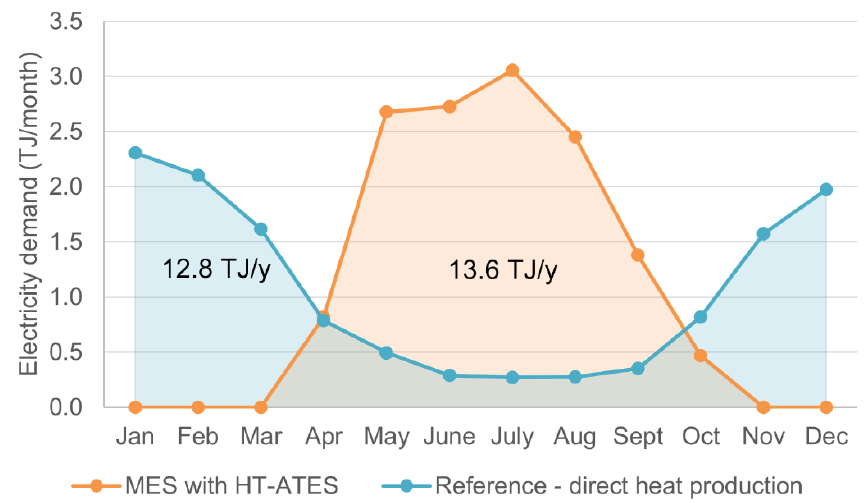
Figure 12. Comparison of the monthly electricity demand of a reference scenario with direct heat production by a heat pump with 8 °C evaporator temperature and the 50|30|1.5 scenario with HT-ATES. The areas under the graph show the total electricity demand over the year, in this case the year 2019.